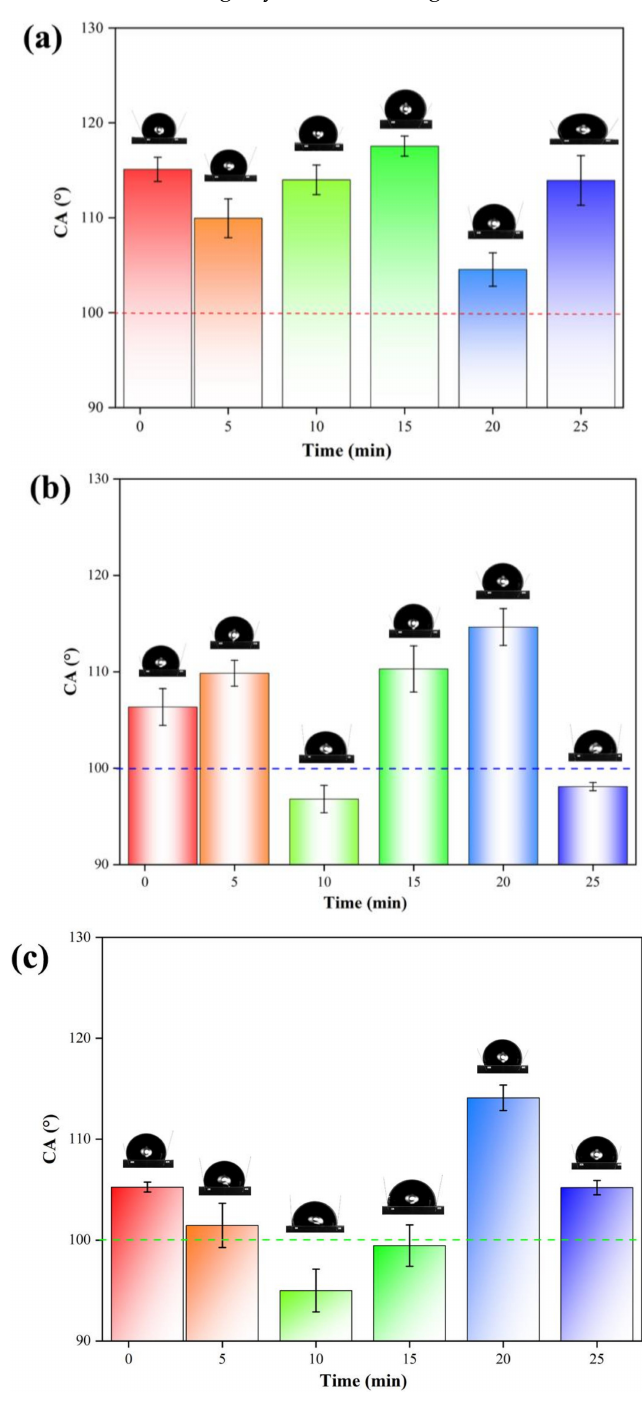
Figure 8. Contact angle of wood surface coating with different electroless Ni time (( a ): once electroless Ni, ( b ): twice electroless Ni and ( c ): three times electroless